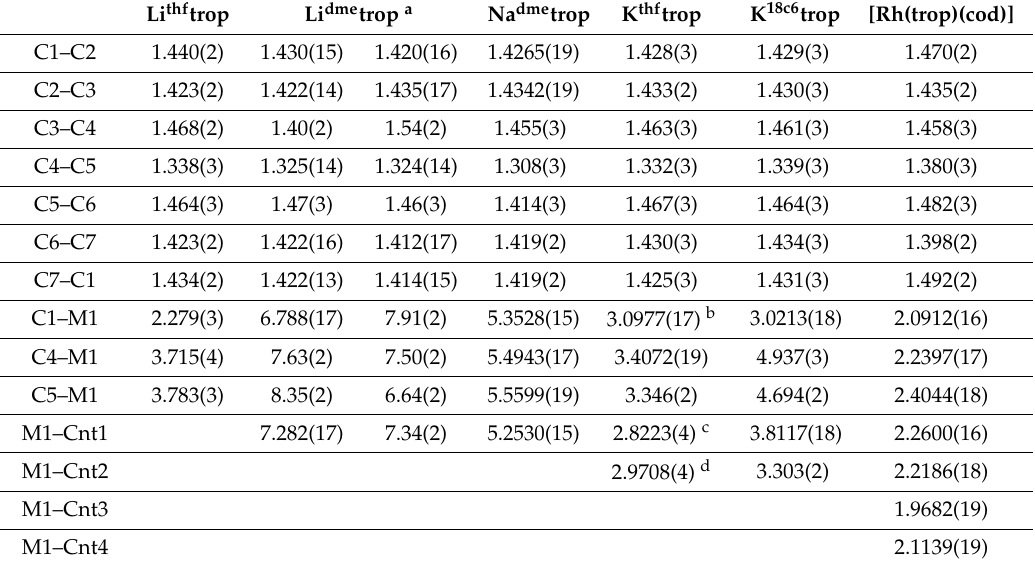
Table 2. Selected bond lengths (Å) for the trop anions (Figure 1). Abbreviation: Cnt: centroid.